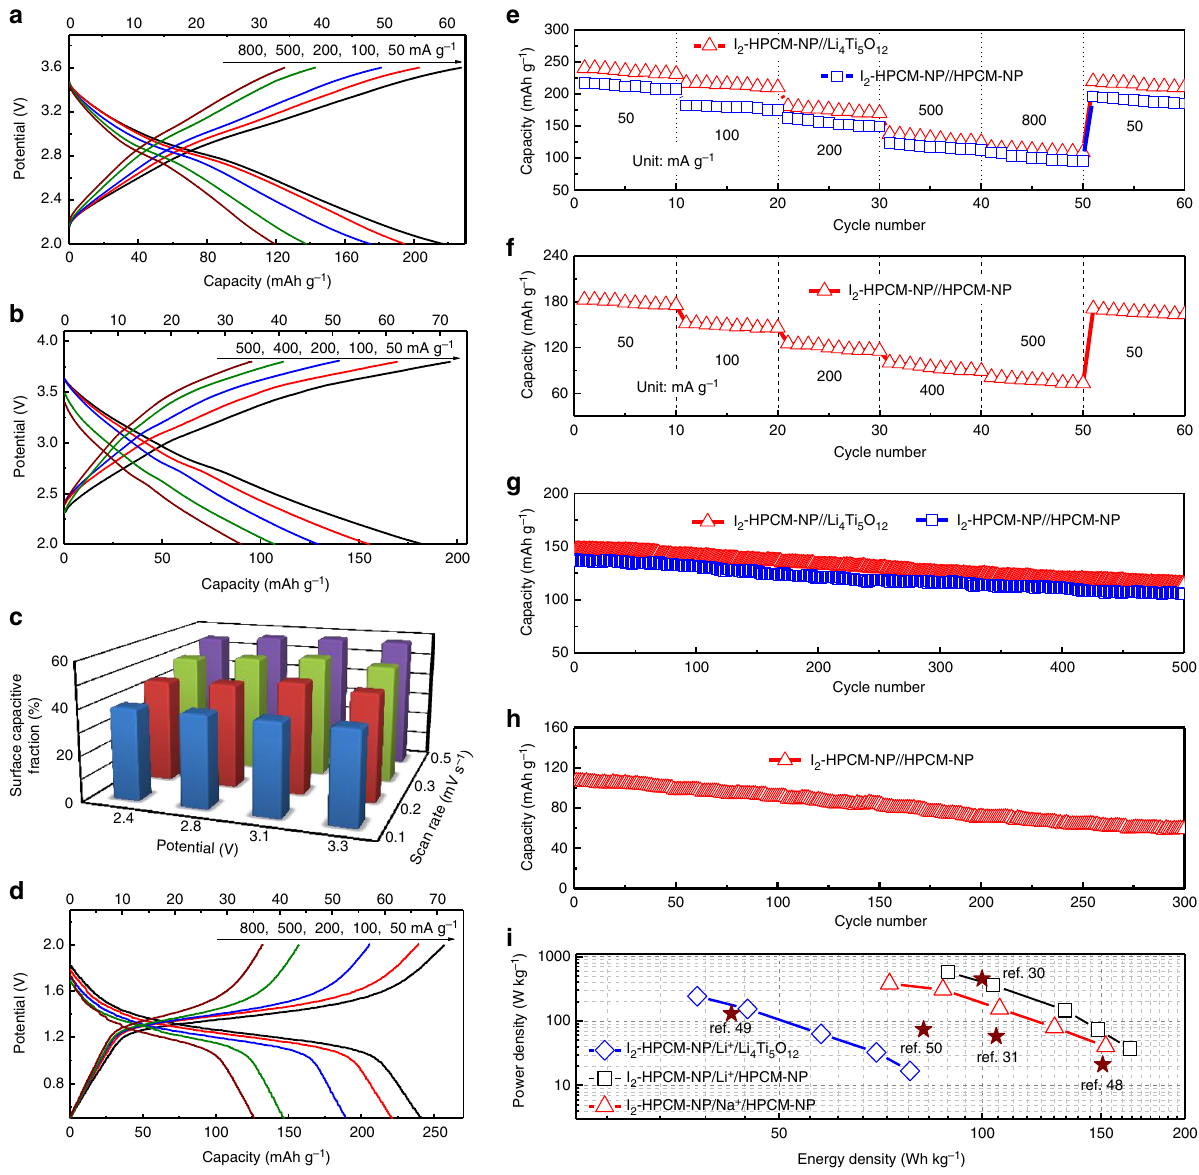
Fig. 5 Electrochemical performance of iodine – carbon hybrid full battery. Charge/discharge curves at different rates of I 2 -HPCM-NP//HPCM-NP in a LiTFSI and b NaClO 4 , respectively, and the corresponding discharge capacities ( up : based on the weight of anode and cathode; down : based on the weight of carbon-based electrodes). c Surface pseudocapacitance (redox) contributions at different conditions. d Charge/discharge curves at different rates of I 2 -HPCM-NP//Li 4 Ti 5 O 12 full battery and the corresponding discharge capacities ( up : based on the weight of anode and cathode; down : based on the weight of carbon-based electrodes). e , f Rate capability and g , h cycling performance of different hybrid full batteries with e , g LiTFSI and f , h NaClO 4 . i Ragone plot of full batteries, where power and energy densities are estimated based on the total mass of cathode and anode